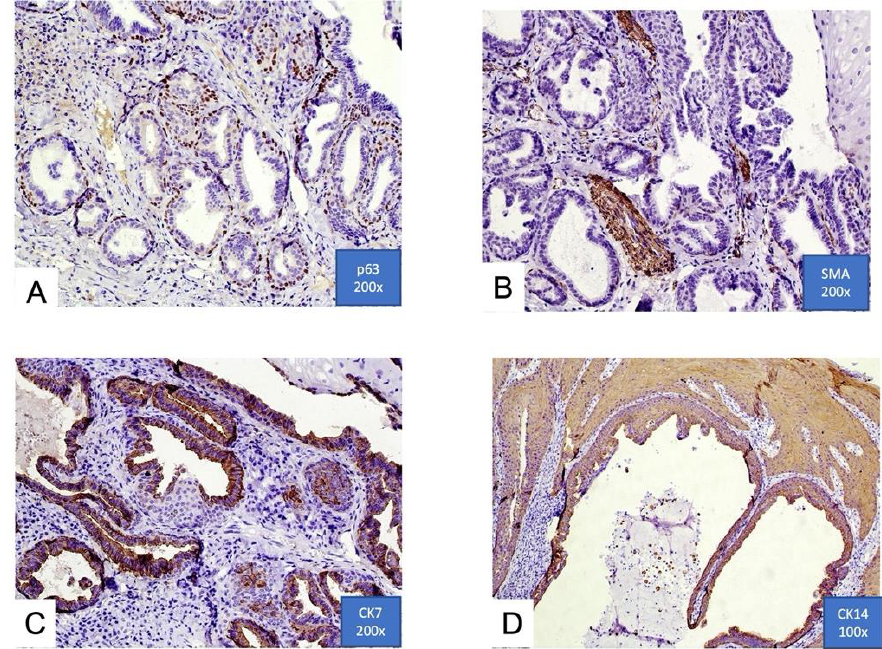
Figure 3. ( A , B ) Focal immunohistochemical positivity for p63 and smooth muscle actin (SMA). Immunoreactivity for p63 in basal cells of ductal structures suggesting a myoepithelial immunophe- notype. Positivity of ductal structures is also evident; ( C , D ) positive immunohistochemical expression for cytokeratins 7 and 14 (CK7 and CK14) in ductal luminal cells, possibly confirming the epithelial origin (100 × and 200 ×